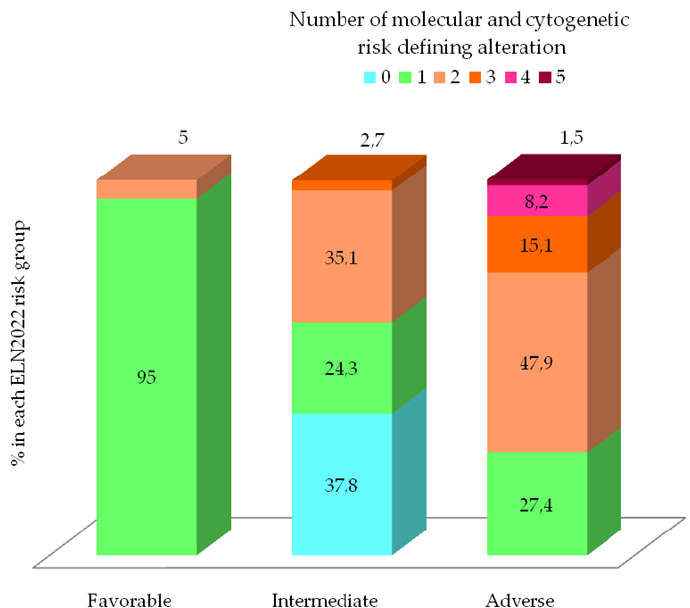
Figure 2. Number of molecular and cytogenetic risk defining alteration according to ELN2022 and distribution acrooss ELN2022 prognostic risk group.